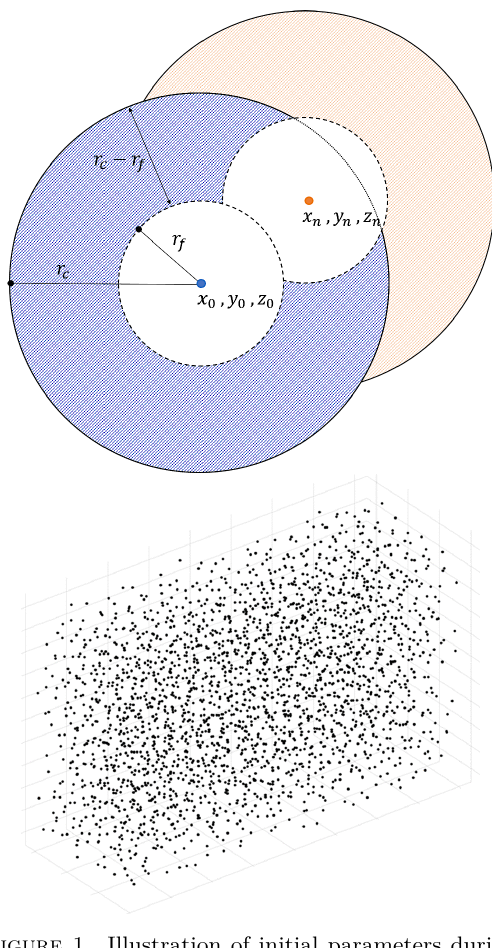
Figure 1. Illustration of initial parameters during domain filling. No more points can exist in white cir- cle (upper image). Results of filling the 3-dimensional space with uniform points distributions (lower im- age).